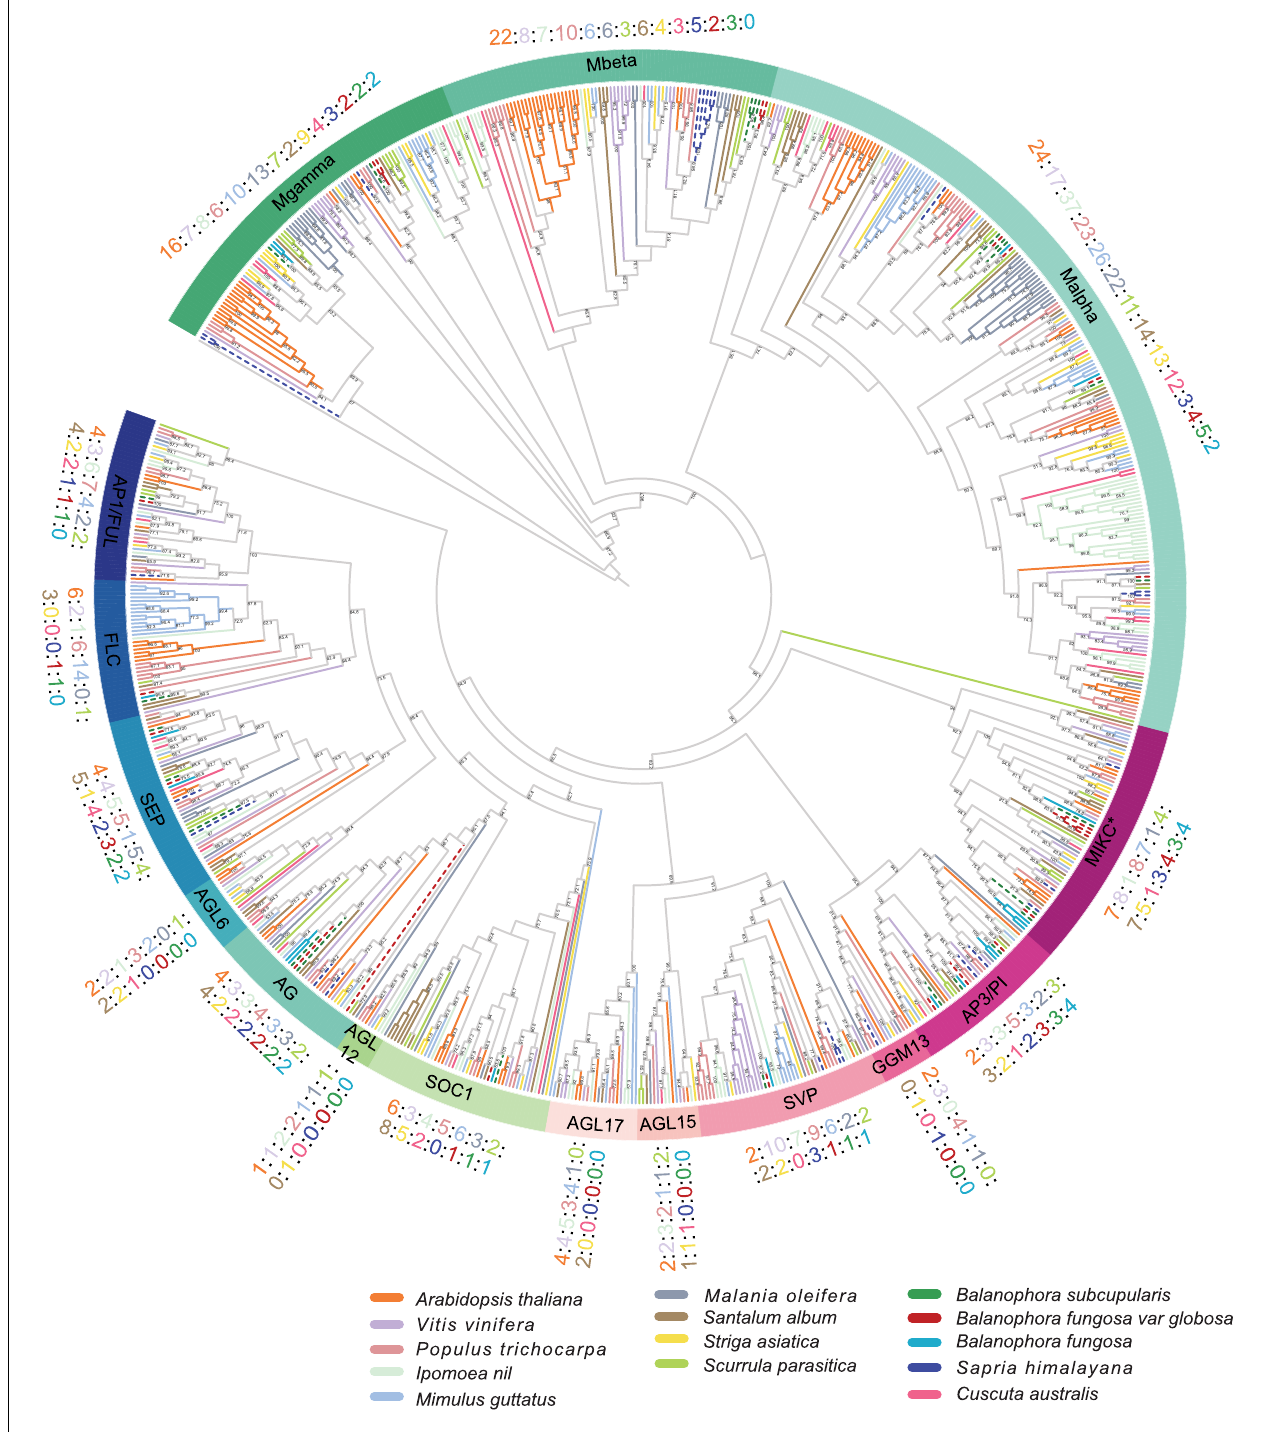
FIGURE 2 | Phylogenetic tree of MADS-box genes in B. subcupularis , B. fungosa var. globosa , and reference species. The phylogenetic tree was constructed using the maximum likelihood (ML) method of IQ-TREE program (see text footnote 7). And visualized and decorated the tree by Evolview (see text footnote 8). Taking Arabidopsis as a reference, the tree was divided into 16 subfamilies (Smaczniak et al., 2012; Fatima et al., 2020). Different species are represented in different colors. Orange, green, blue, and red dotted lines represent Arabidopsis , B. subcupularis , S. himalayana , B. fungosa var. globosa , respectively. The numbers show the number of MADS-box genes of parasitic plants and reference species in each subfamily. The Bootstraps are ≥ 50. See Supplementary Figure 2 for more details. The alignment information of these genes are available in Supplementary Table 9 .